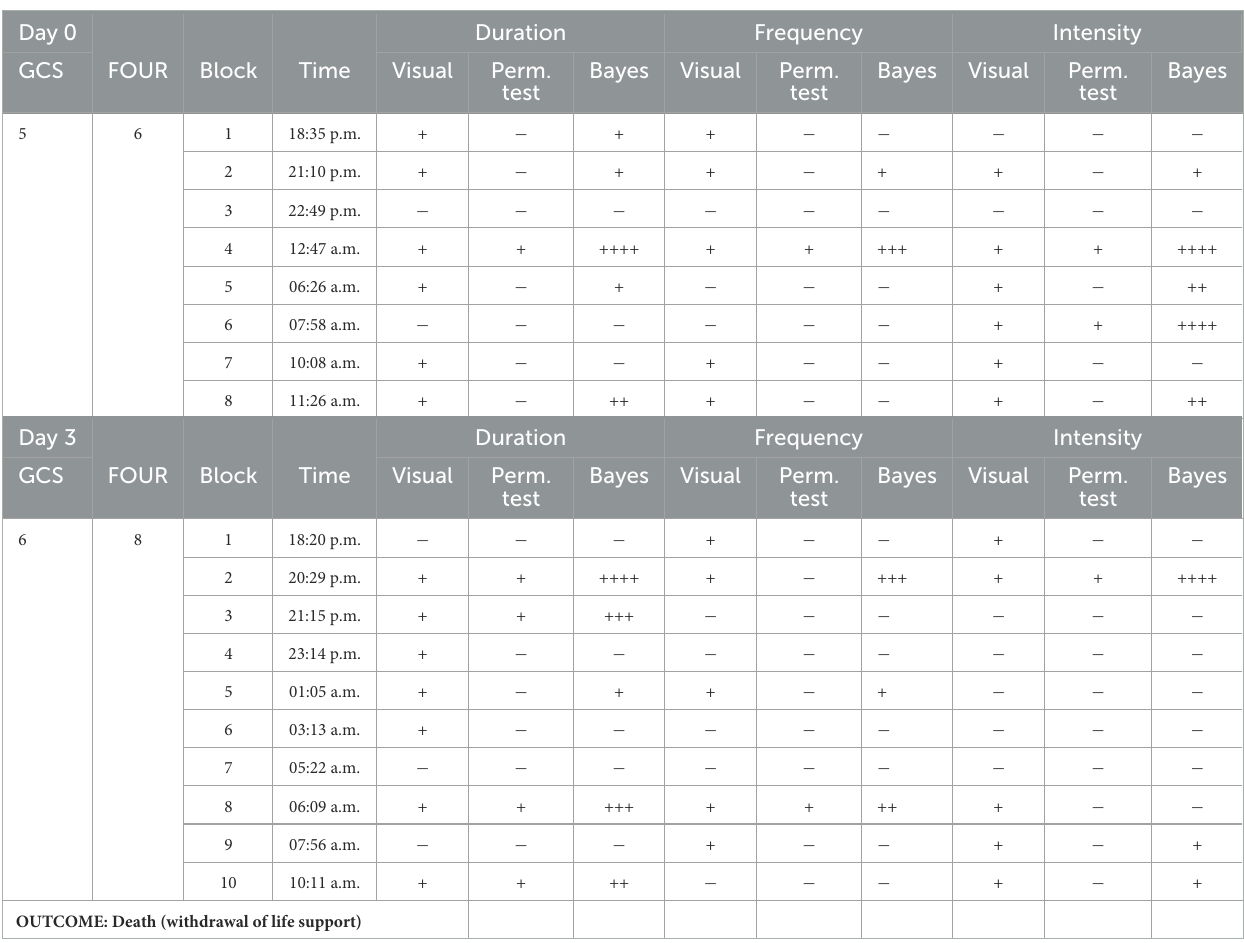
TABLE 4 Summary of the MMN results in Patient 1. Day 0 Duration Frequency Intensity GCS FOUR Block Time Visual Perm.